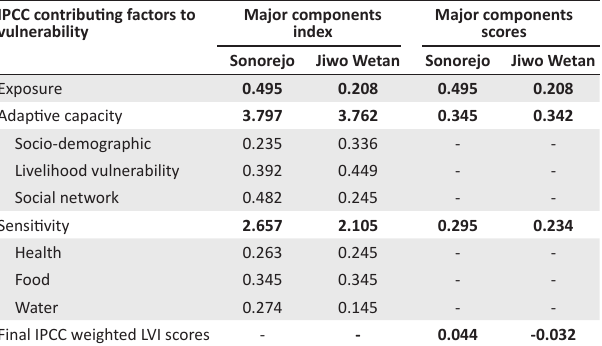
TABLE 5: Calculation of Livelihood Vulnerability Index-Intergovernmental Panel on Climate Change contributing factors in the Sonorejo Village and Jiwo Wetan